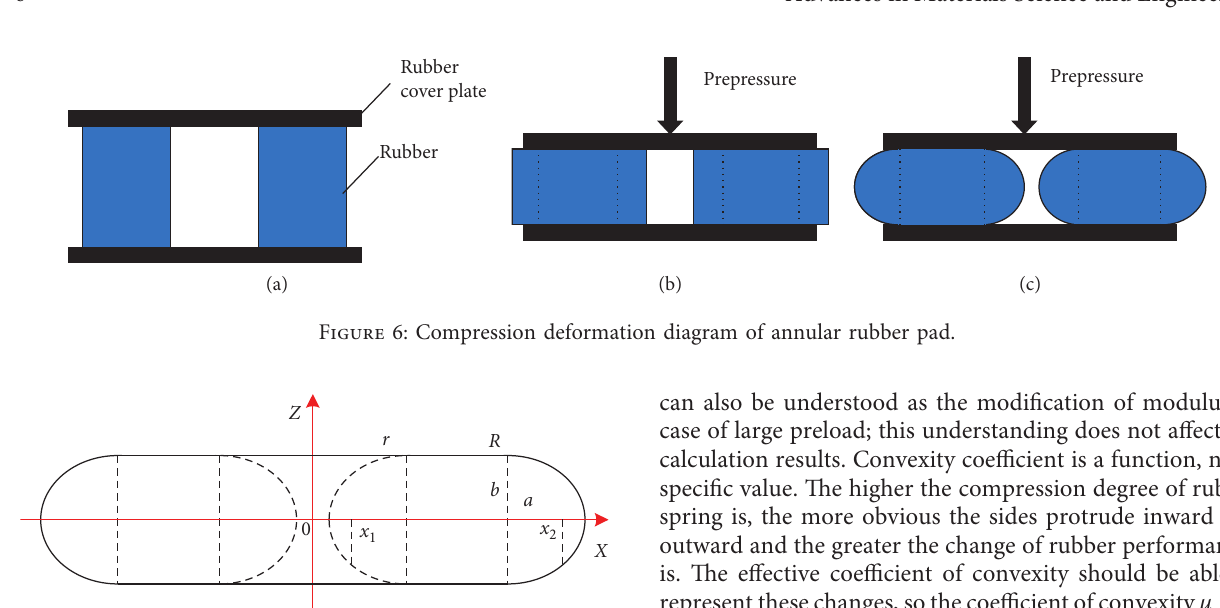
Figure 7: The vertical section profile of Figure